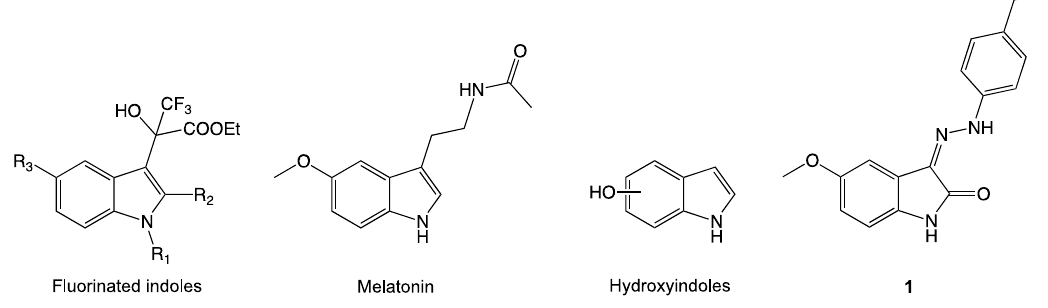
Figure 1. Structures of indole derivatives endowed with amyloid anti-aggregating properties.